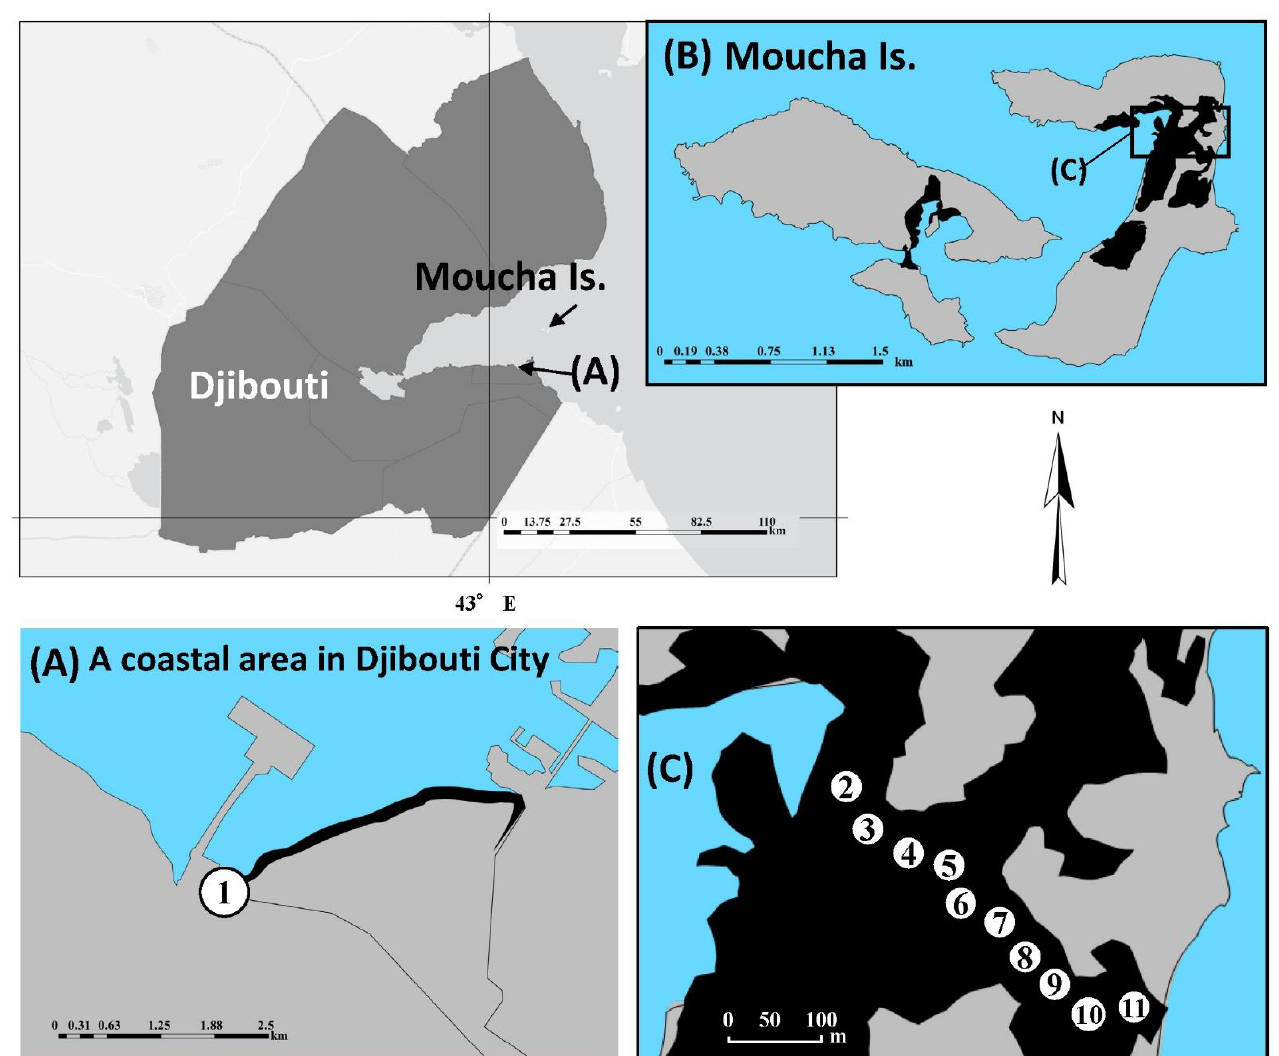
Figure 1. Location of study sites in this study: ( A ) Site A: a coastal area in Djibouti City, ( B ) Moucha Island, and ( C ) an area along a creek on Moucha Island. Numbers in circles show survey points. Plant samples were collected from Points 1, 2, 5, 8, and 11; soil water samples from Points 3, 5, 7, and 9; and EC loggers were set at Points 4, 6, 8, and 10. The area in black shows the distribution of mangrove communities.